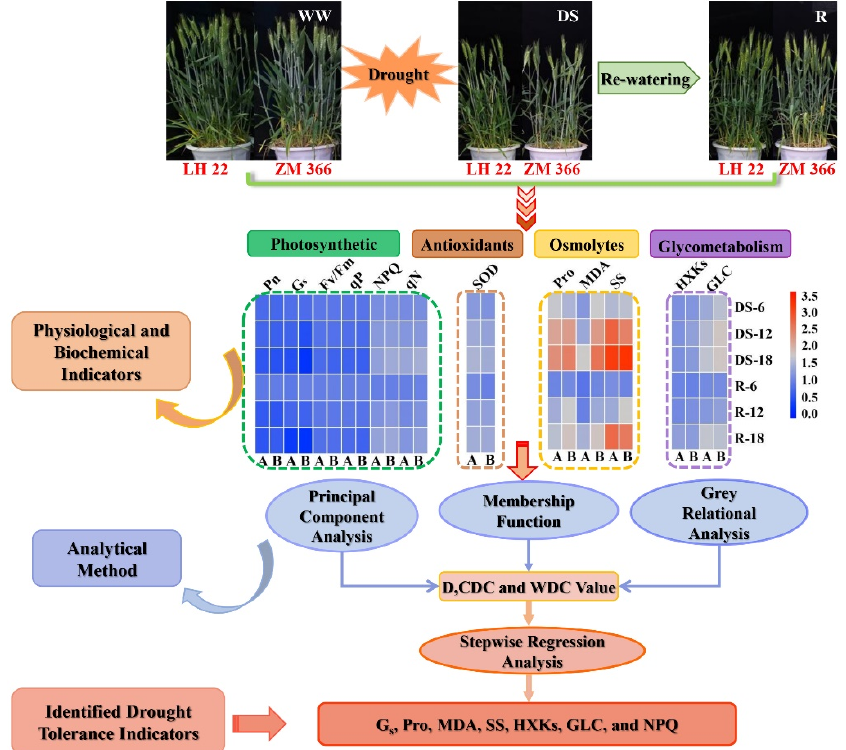
Figure 7. Schematic representation of wheat physiological and biochemical performance and drought tolerance indicators screening under drought and re − watering conditions. A: LH22 (drought − tolerant cultivar), B: ZM366 (drought − sensitive cultivar). WW: well − watered; DS: drought stress; and R 6, R 12, R 18: re − watering after 6, 12, and 18 days of stress treatment, respectively. D, drought tolerance comprehensive evaluation; DC, drought tolerance coefficient; WDC, weight drought tolerance coefficient.